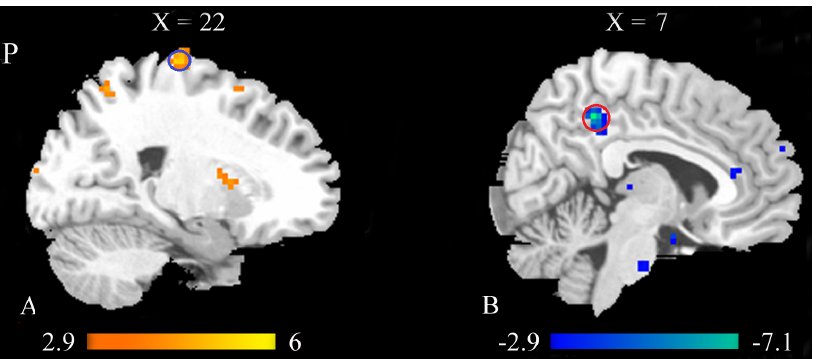
Figure 5. Brain areas with significant different ReHo values between MCI and HC groups during the resting state are shown. Warm and cool colors indicate the significantly increased and decreased ReHo values in MCI patients compared with healthy controls at P , 0.01 (Alphasim